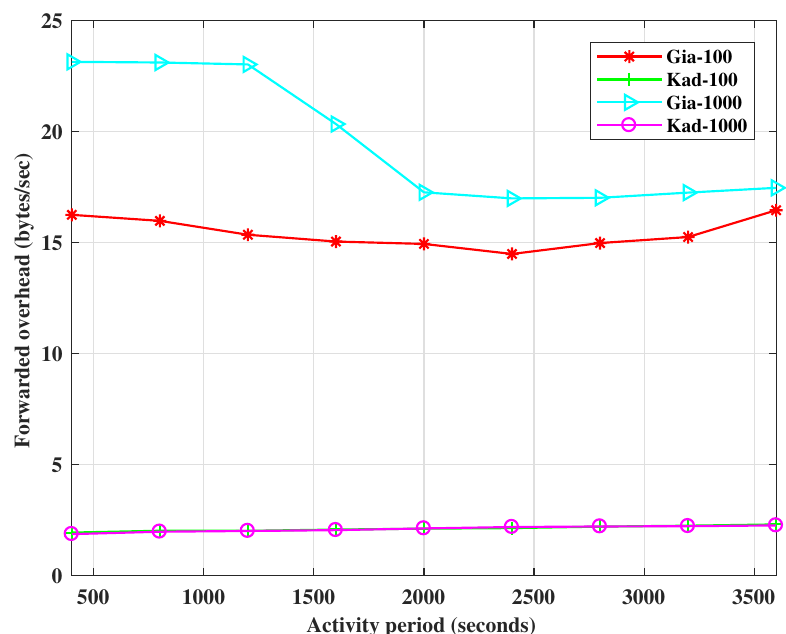
Figure 10. Comparison of the bandwidth overhead forwarded by each peer using Kademlia and Gia P2P protocols.